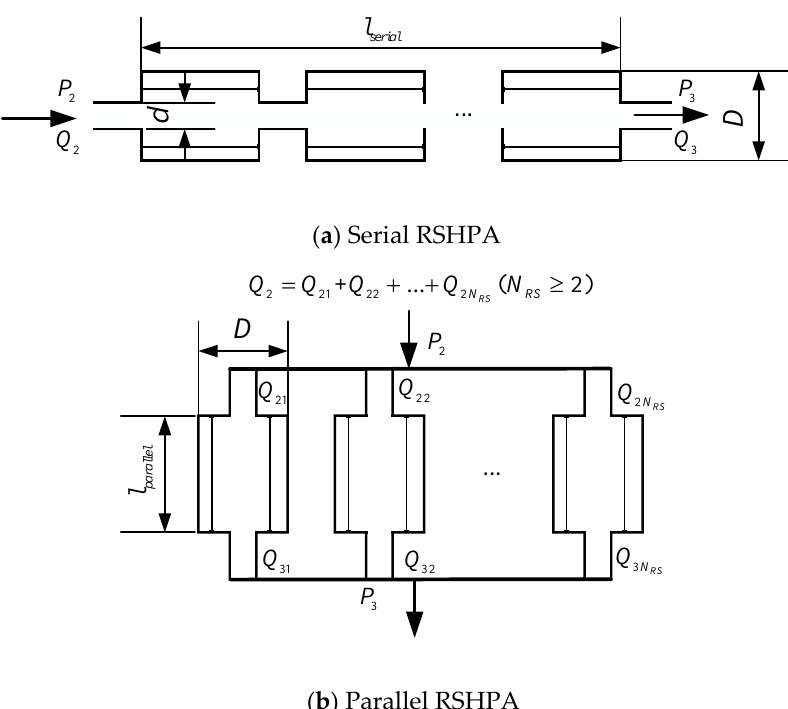
Figure 12. Schematic diagram of serial and parallel combinations of RSHPA.